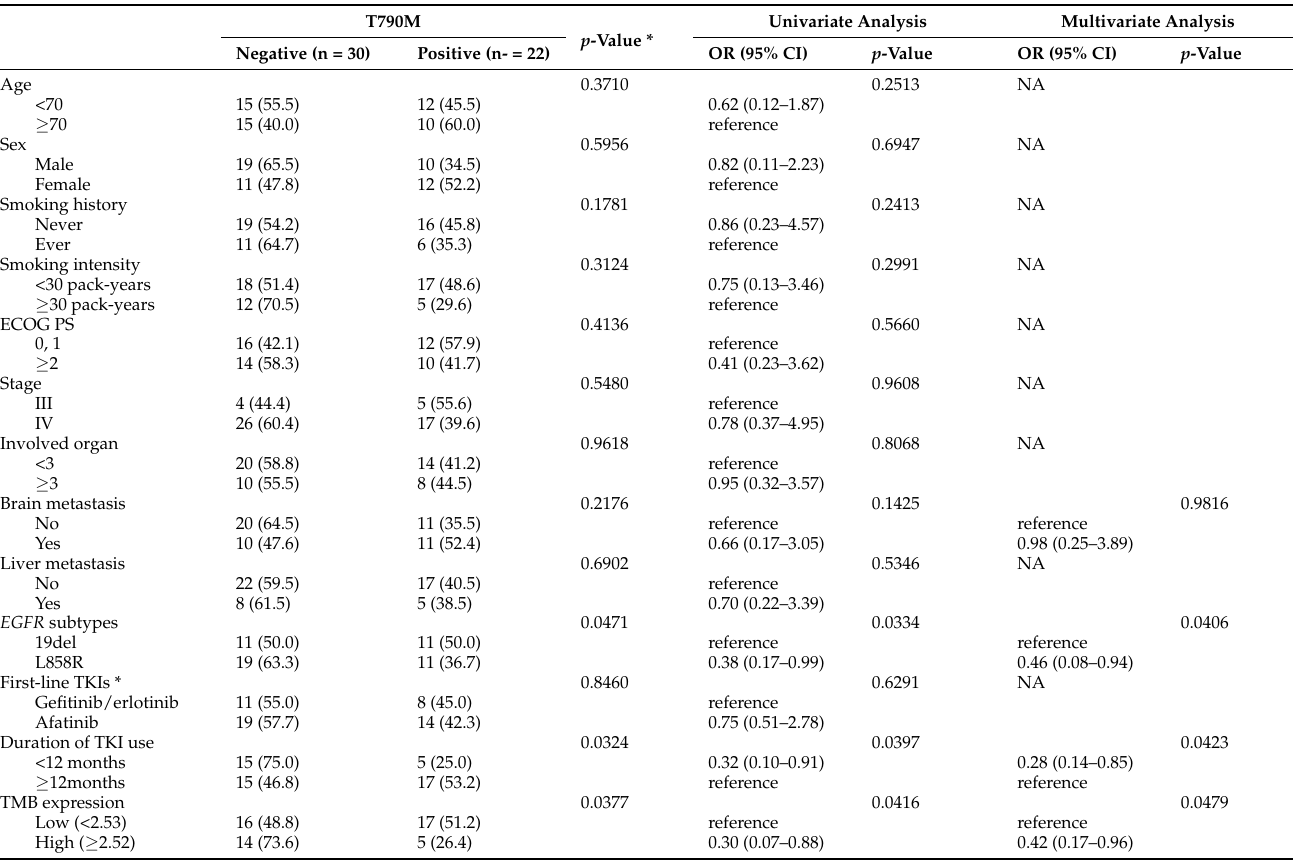
Table 5. Analysis for the factors that were associated with the emergence of secondary T790M mutation (n = 52).